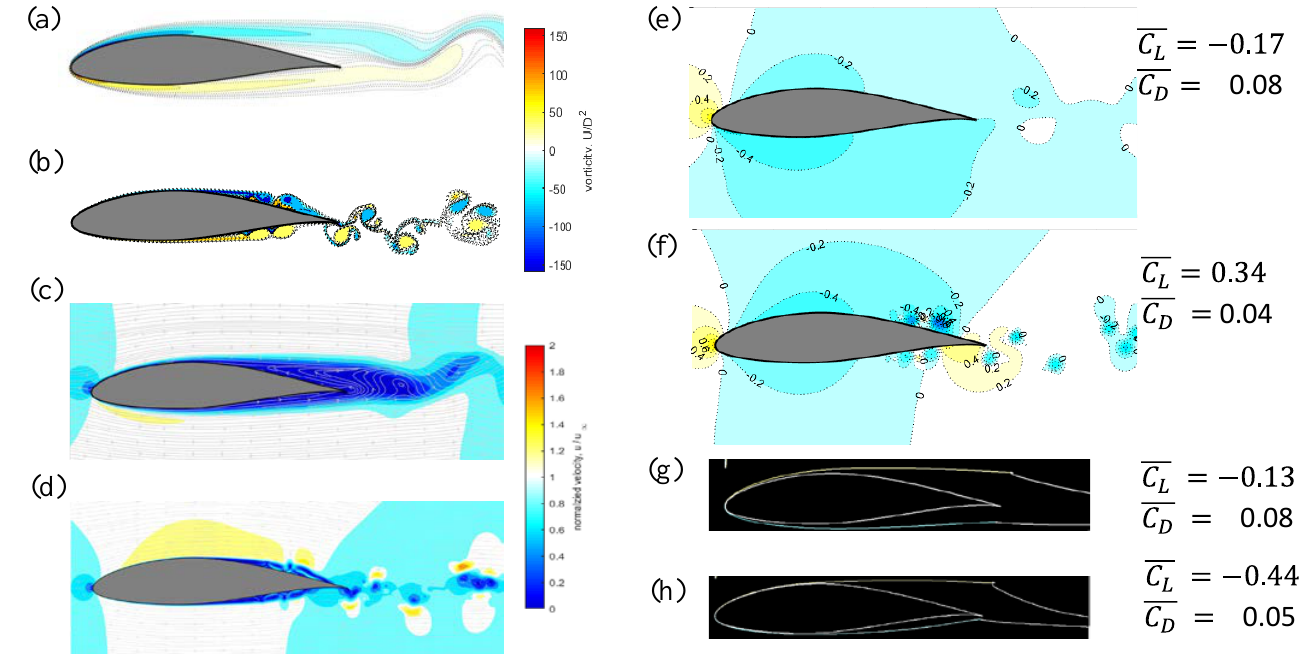
Figure 6. Instantaneous fields of NACA64 airfoil at α = 0 ◦ . Vorticity: ( a ) Re C = 4000 and ( b ) Re C = 60,000. Velocity: ( c ) Re C = 4000 and ( d ) Re C = 60,000. Pressure coefficients, Cp : ( e ) Re C = 4000 and ( f ) Re C = 60,000. Steady-state simulation of boundary layer streamlines by XFOIL: ( g ) Re C = 4000 and ( g ) Re C = 60,000. Note: ( a , c , e ) correspond to the first red star in Figure 5a ( Ut / C = 55.06) while ( b , d , f ) correspond to the first red star in Figure 5b ( Ut / C = 11.68). For ( e – h ), the associated mean force coefficients are attached on the